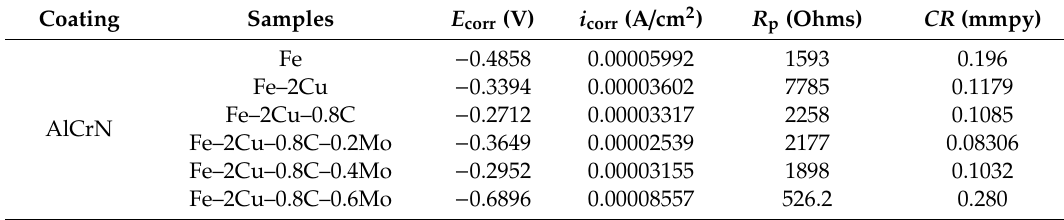
Table 9. Potentiodynamic polarization data attained from the corrosion